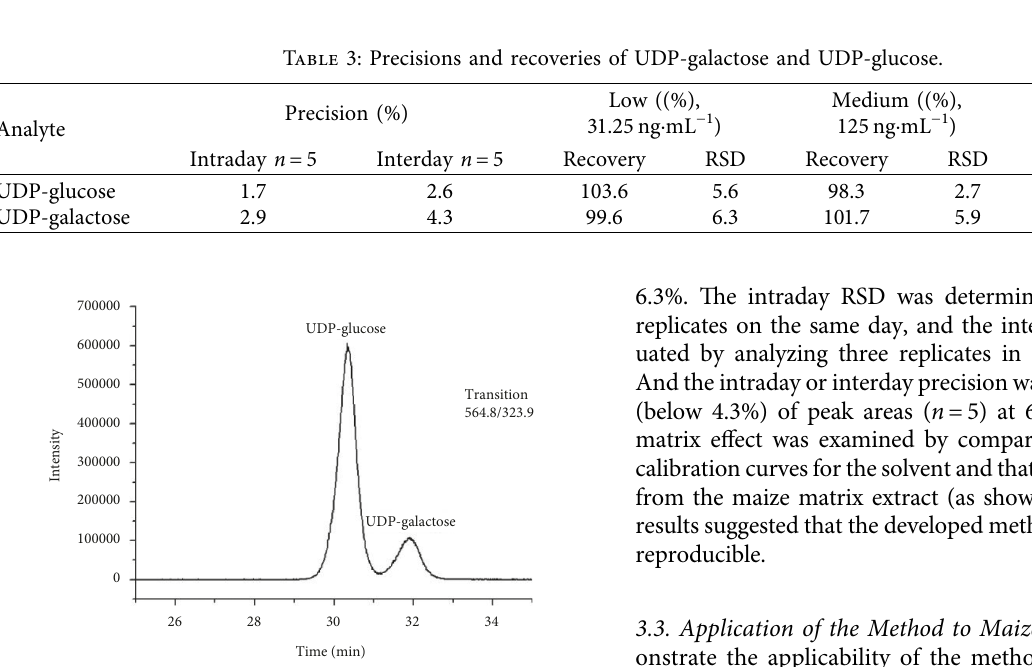
Figure 3: Liquid chromatography-tandem mass spectrometry chromatogram of maize samples